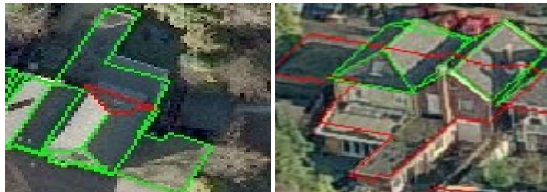
Figure 10. A wrong face identified in oblique image ©Blom (red in the right image) but not identified in nadir images (left)